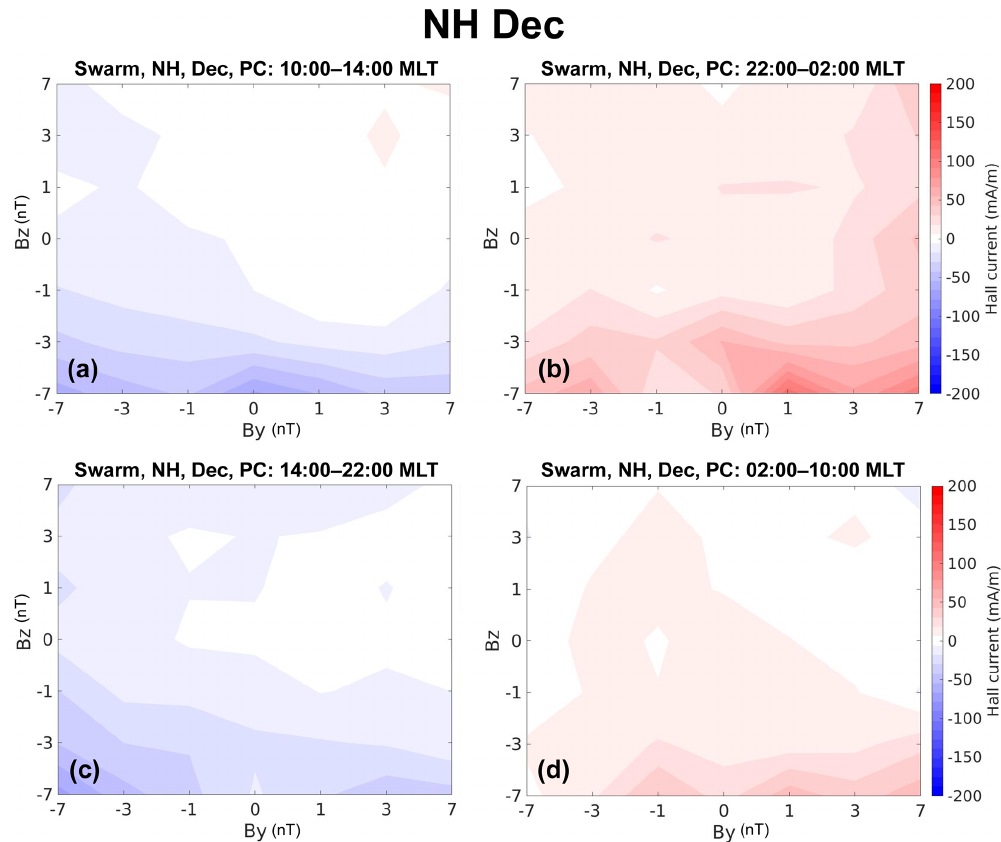
Figure 9. Same format as Fig. 8 but for December solstice (local winter).